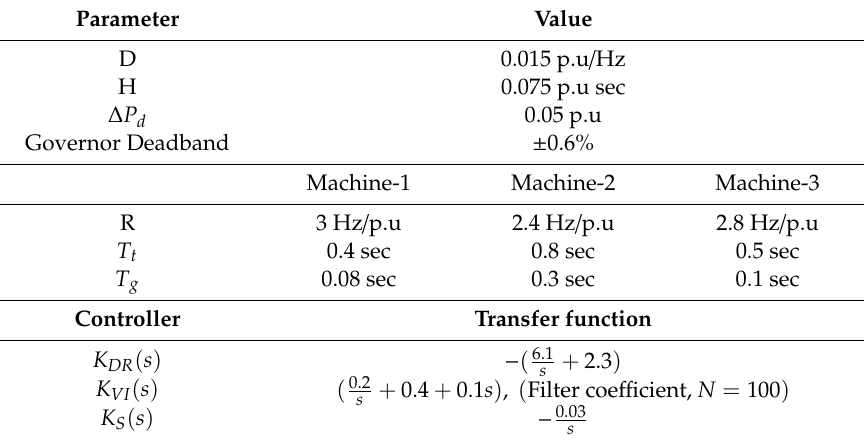
Table 1. Parameters of test system and machines.